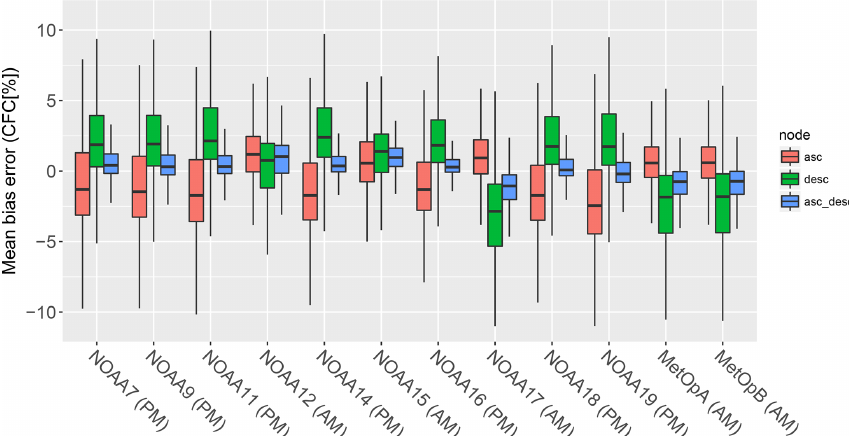
Figure 3. Distribution of the mean CFC bias error caused by the discrete sampling of the CFC diurnal cycle presented for each NOAA satellite (AM – morning – and PM – afternoon) and each node (asc – ascending, desc – descending, and asc_desc – ascending and descending combined). The lower and upper hinges correspond to the 25th and 75th percentiles, while whiskers extend from the hinge to the largest and lowest values within 1.5 times the interquartile